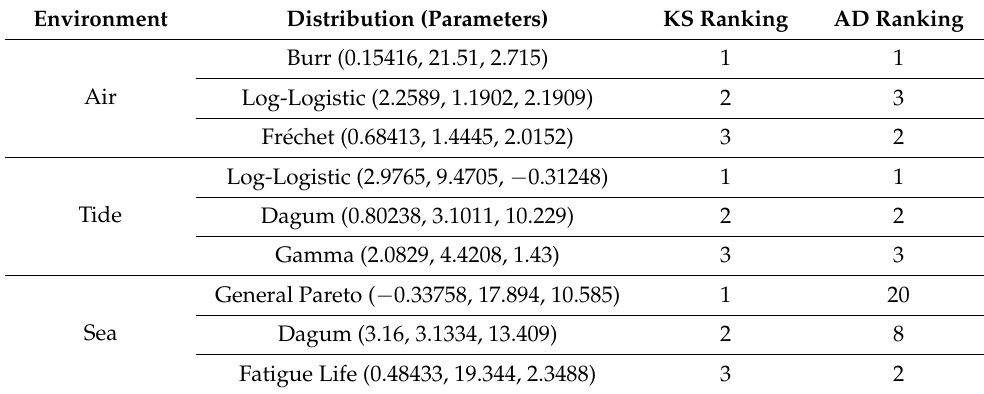
Table 11. The three best-fitted three-parameter distributions for the NiTi-2 alloy in air, tide and sea